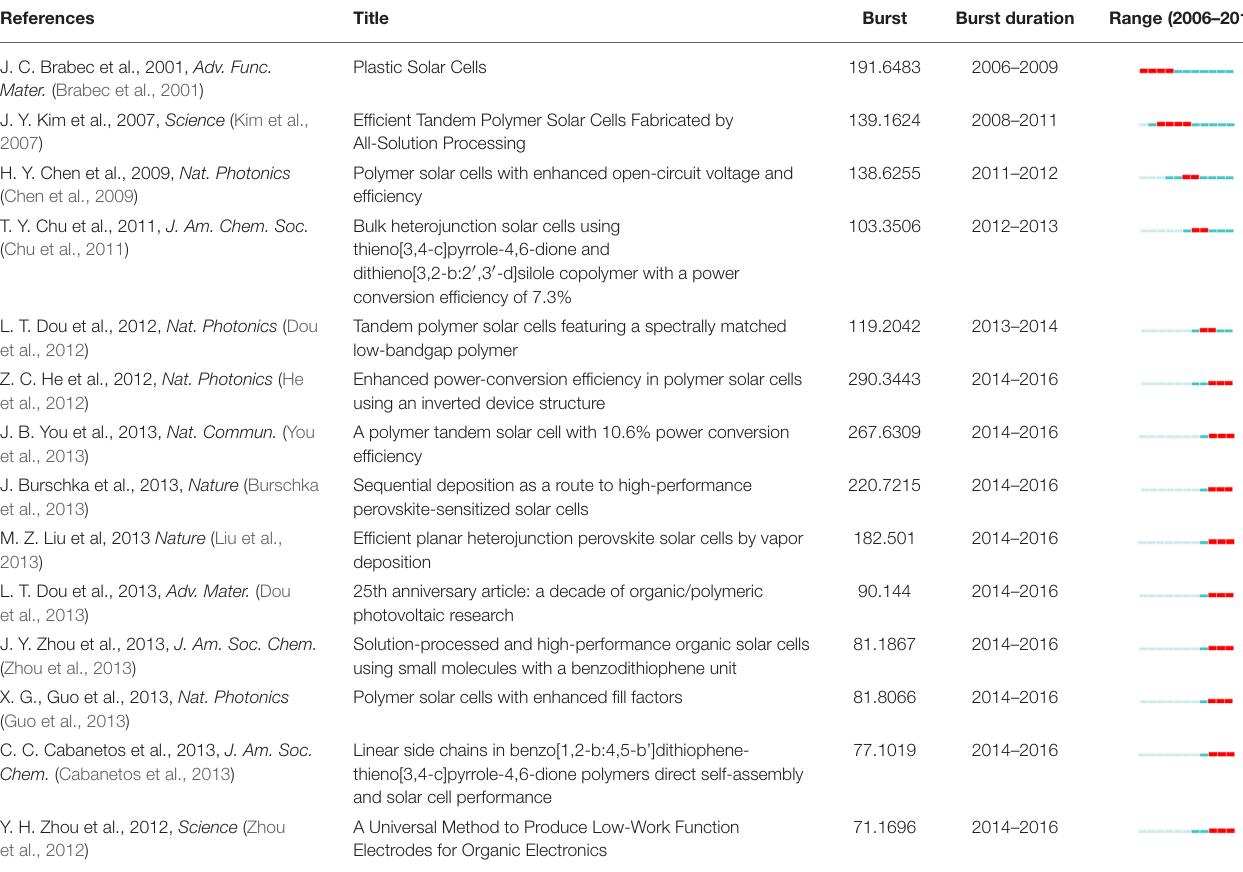
TABLE 5 | Representative references ranked by the beginning time of